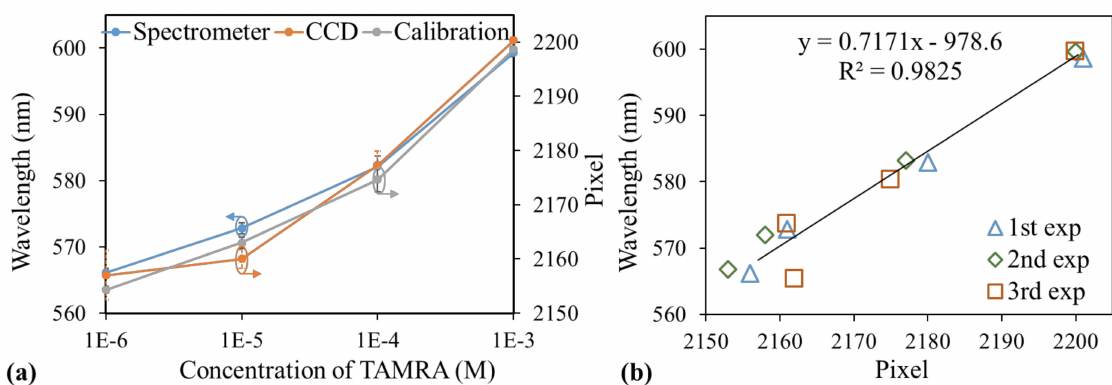
Figure 5. ( a ) Peak wavelength (blue), measured MICP (orange), and expected MICP (gray) based on the calibration diagram as a function of the concentration. ( b ) Correlation between the peak wavelength and the